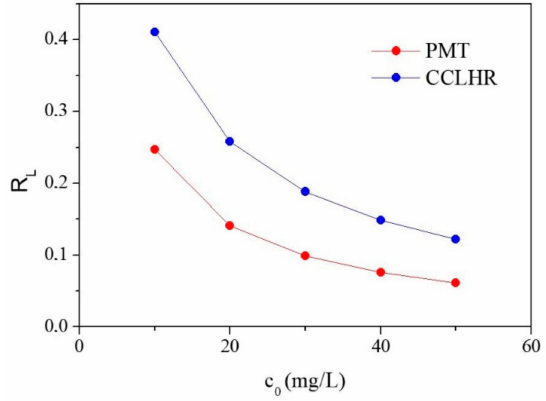
Figure 9. Curve of R L by the initial concentration for PMT and